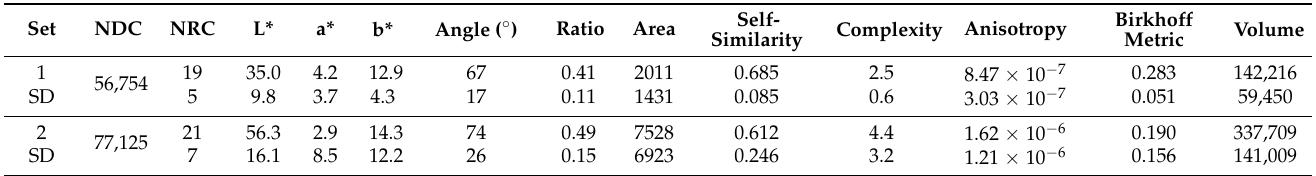
Table 1. Statistical descriptors (average and standard deviation) derived from the two image datasets used. Row number 1 presents data from the Prado set, and row number 2 present the results from the Khan set. Set